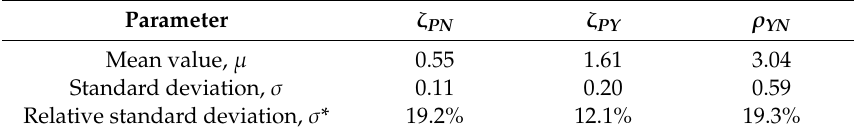
Table 5. Statistical parameter values of the EMA damping ratios and corresponding fraction.